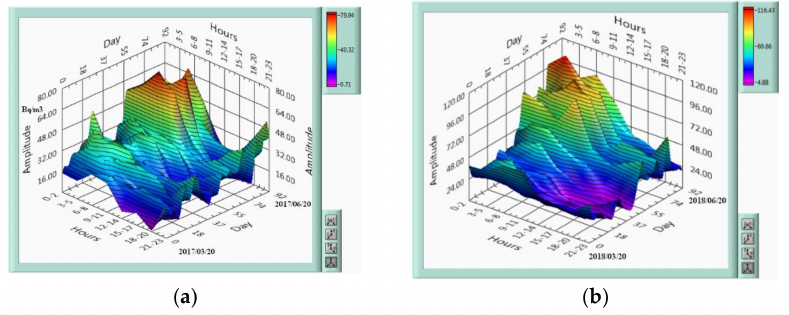
Figure 4. Radon evolution in Bisoca station spring: ( a ) 2017; ( b ) 2018.